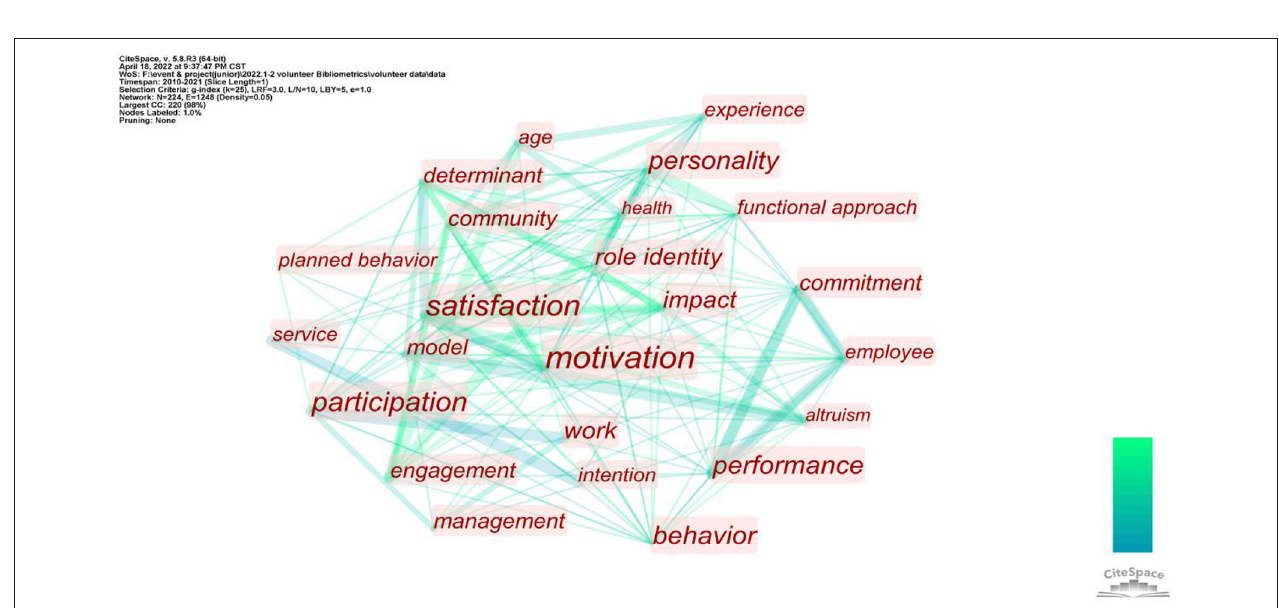
FIGURE 4 | Keyword network between 2000 and 2010 (Threshold for inclusion is a minimum of two occurrences).